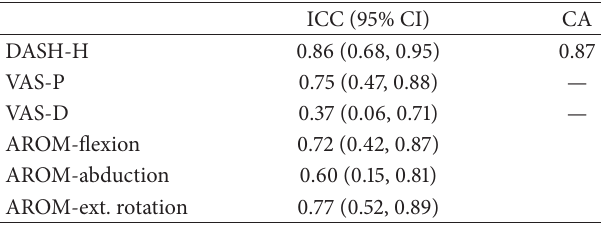
Table 2: Reliability and internal consistency ( 𝑁 =